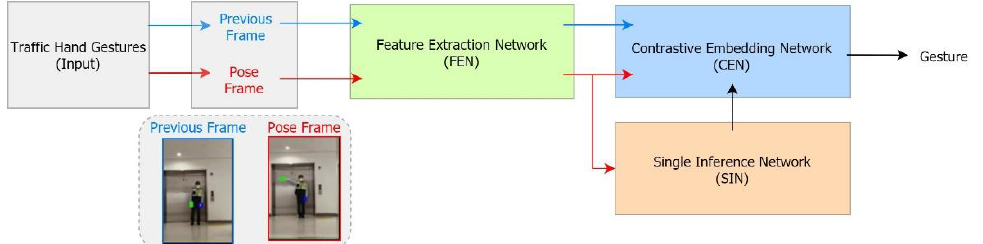
Figure 7. Proposed CNN classifier architecture. It uses FEN to extract features and, by combining results of CEN and SIN, recognizes the traffic-control gestures.